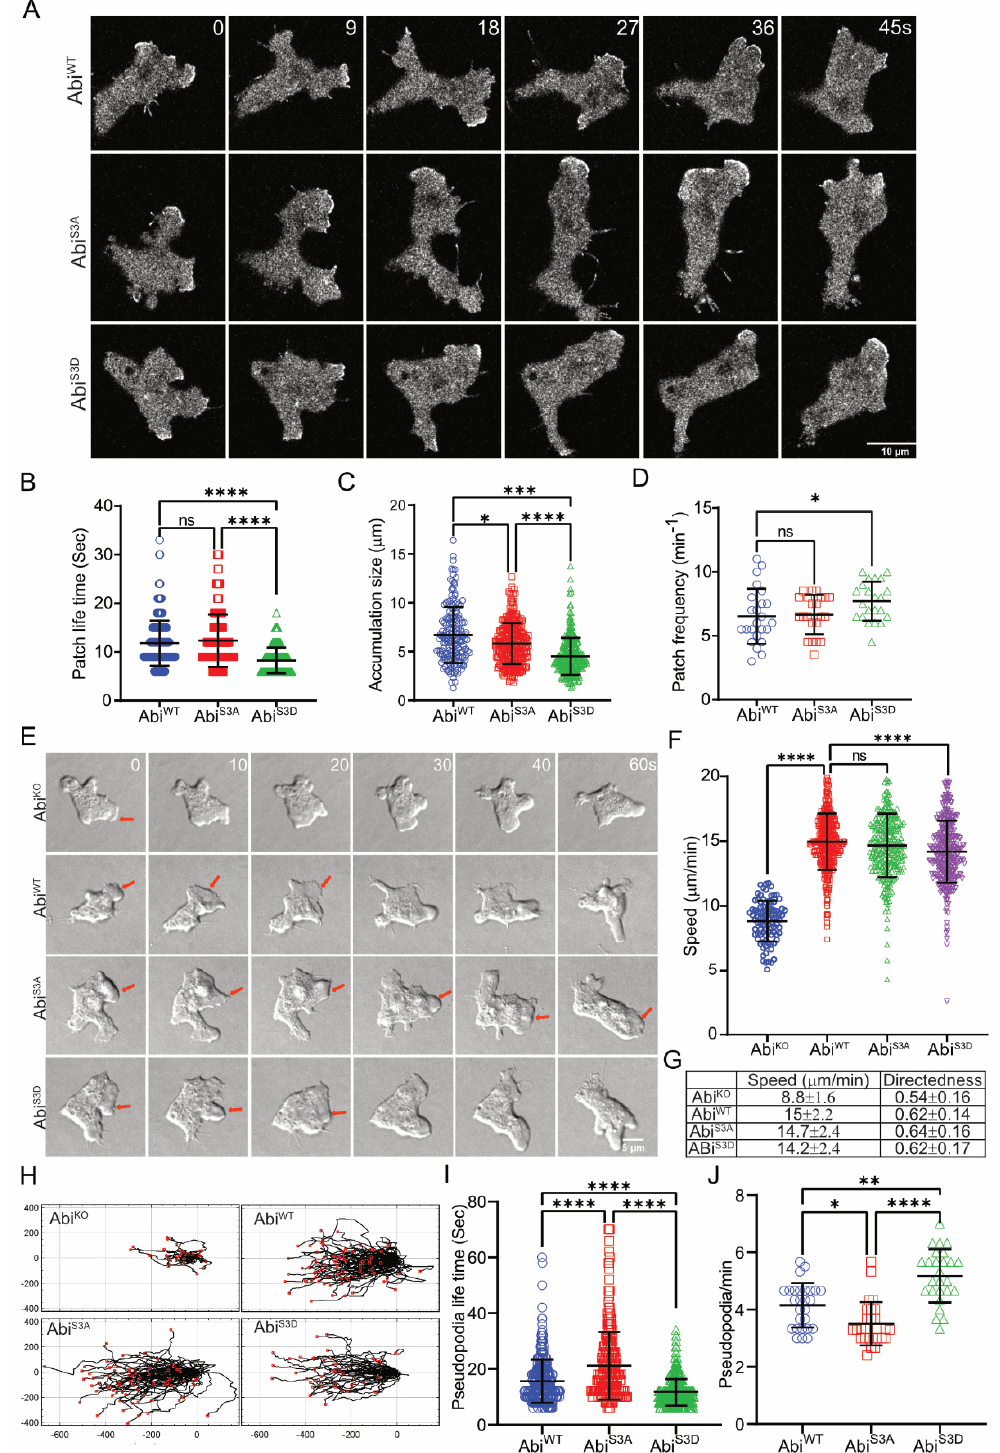
Figure 5. Abi mutants are recruited to pseudopodia and are functional. ( A ) Subcellular localization of Scar complex. Abi WT , Abi S3A , and Abi S3D were co-expressed with HSPC300 − eGFP in Abi- cells, allowed to migrate under agarose up a folate gradient and examined by AiryScan confocal microscopy at a frame interval of 3 s (1f/3s). All show efficient Scar/WAVE complex localization to patches at the pseudopods. ( B – D ) Lifetimes, size, and generation rates of mutant Scar patches. Patch lifetime was measured from the number of frames a patch showed the continuous presence of labelled Scar complex, size was measured as the peak length of contiguous recruitment along the circumference of the cell from individual frames and generation frequency was calculated from the number of patches lasting at least 2 frames. Abi WT and Abi S3A patches